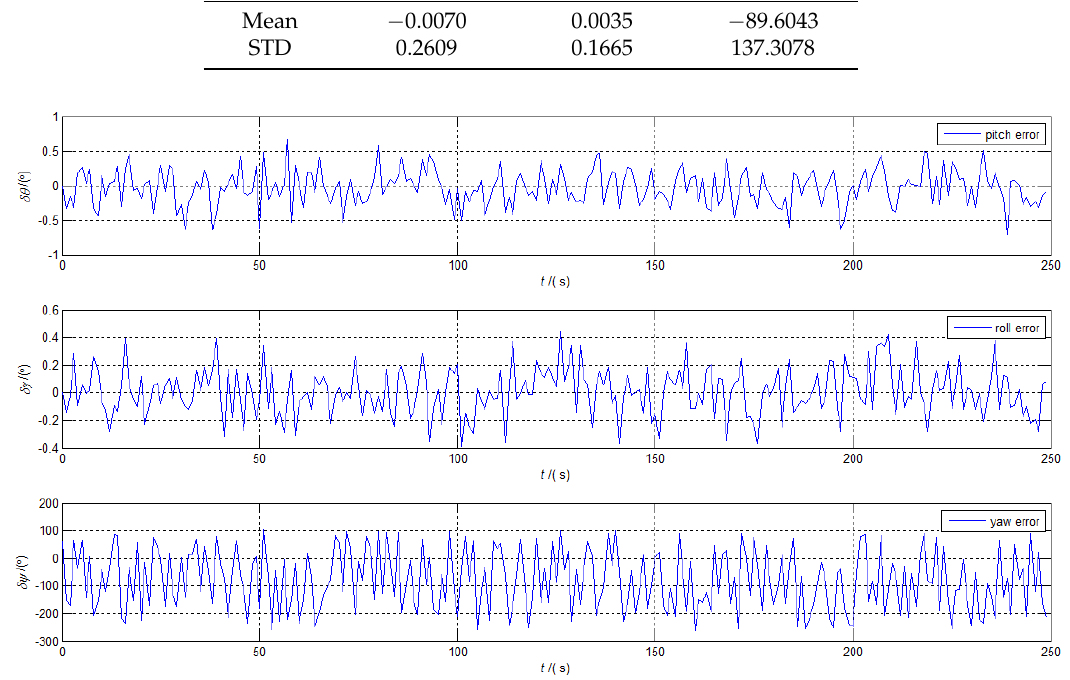
Figure 2. The alignment errors of the Gravitational Apparent Motion